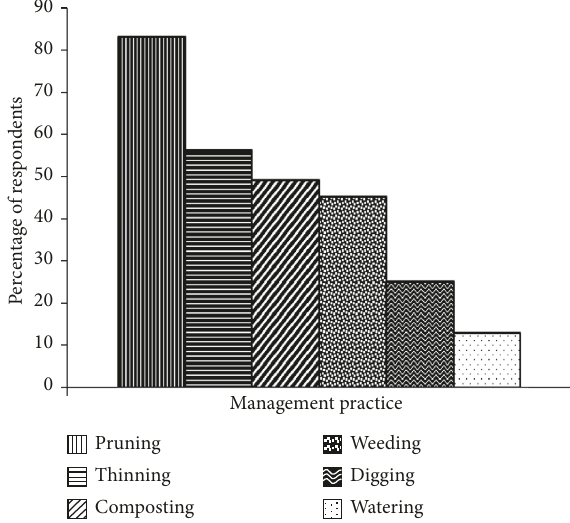
Figure 2: Woody species management practices and percentage of